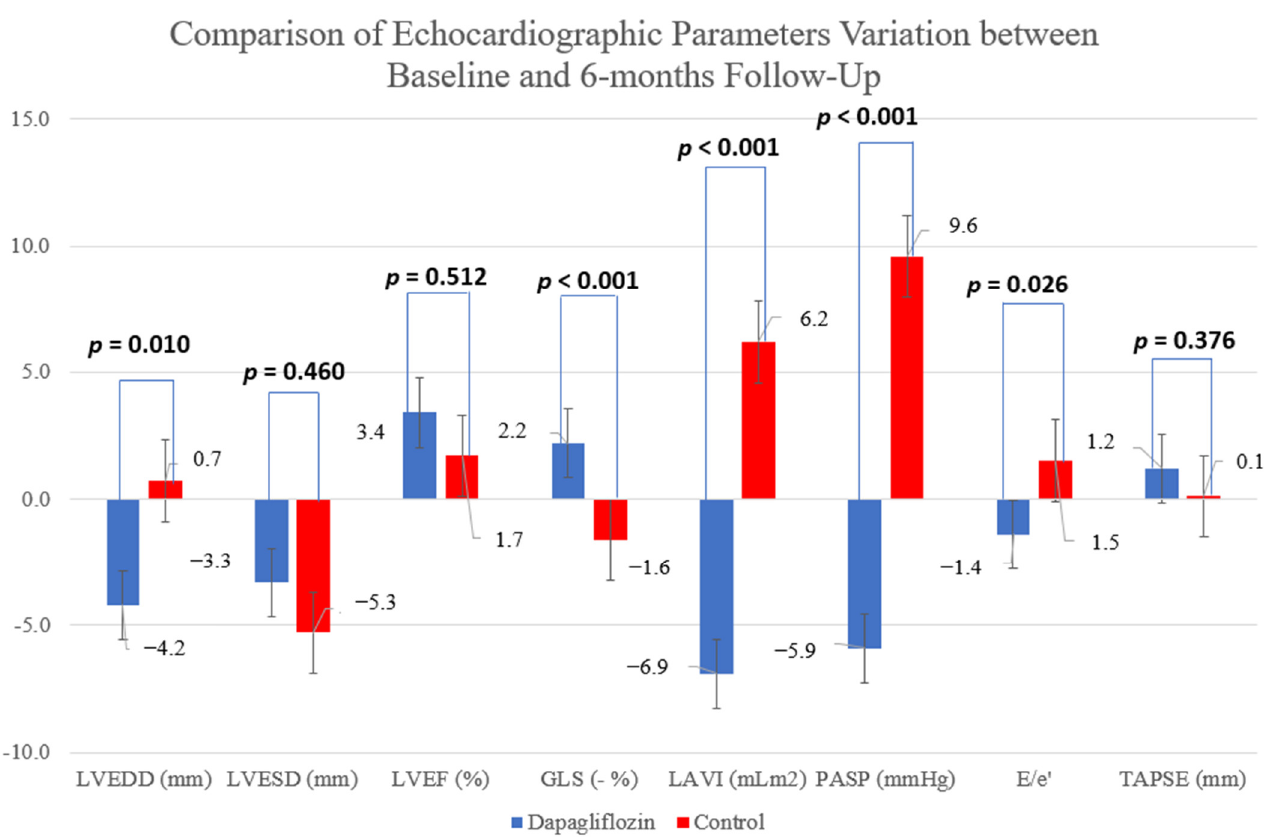
Figure 3. Comparison of CPET parameters variation between baseline and 6 month follow-up.